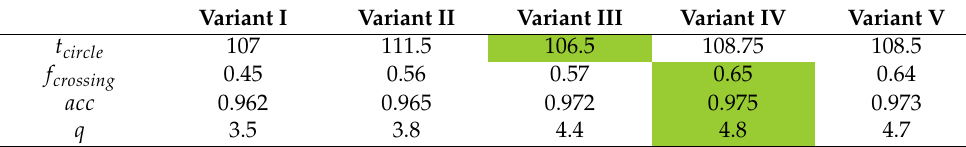
Table 4. Values of performance metrics obtained for five variants of (cid:101) χ updating; simulation scenario Cloud 2